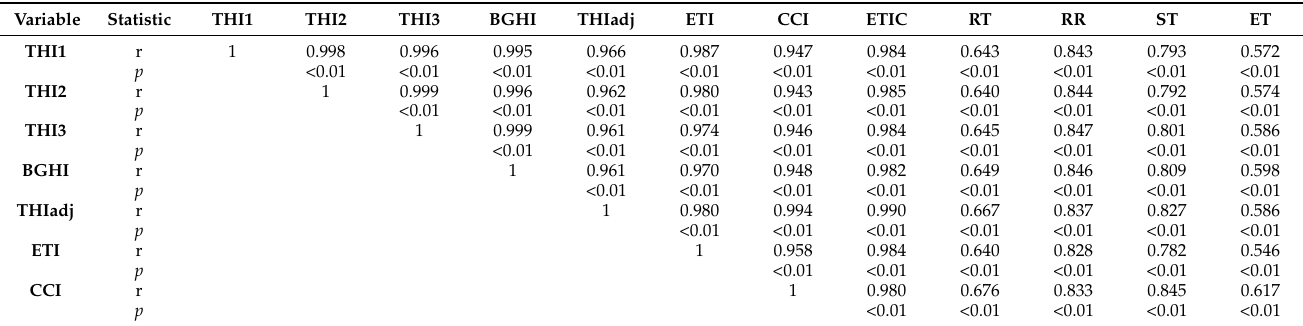
Figure 8. Effect of the thermal index values on skin temperature. The interquartile range (IQR) is shown by a blue box, the median as a blue horizontal line, the mean as a red square, and the whiskers extend to 1.5 IQR. Outliers are indicated by blue dots. An asterisk indicates a significant ( p < 0.05) change in the variable. The thermal indices are the temperature– humidity index (THI1 ( a ), THI2 ( b ), THI3 ( c )), black globe humidity index (BGHI ( d )), adjusted THI (THIadj ( e )), equivalent temperature index (ETI ( f )), comprehensive climate index (CCI ( g )), and equivalent temperature index for dairy cattle (ETIC ( h )). Table 3. Pearson correlation coefficients between thermal indices and animal-based